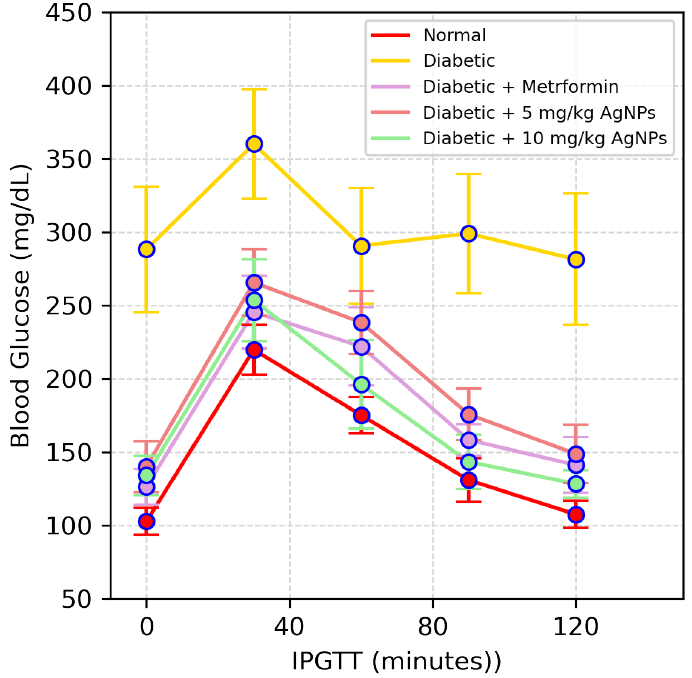
Figure 13. IPGTT results of the healthy, diabetic, metformin-treated and AgNP-treated low (5 mg/kg) and high dose (10 mg/kg) mice post treatment. The statistical significance of differences among different groups was analyzed using Two Way ANOVA Bonferroni test as implemented in Graph pad prism 5.0 software.